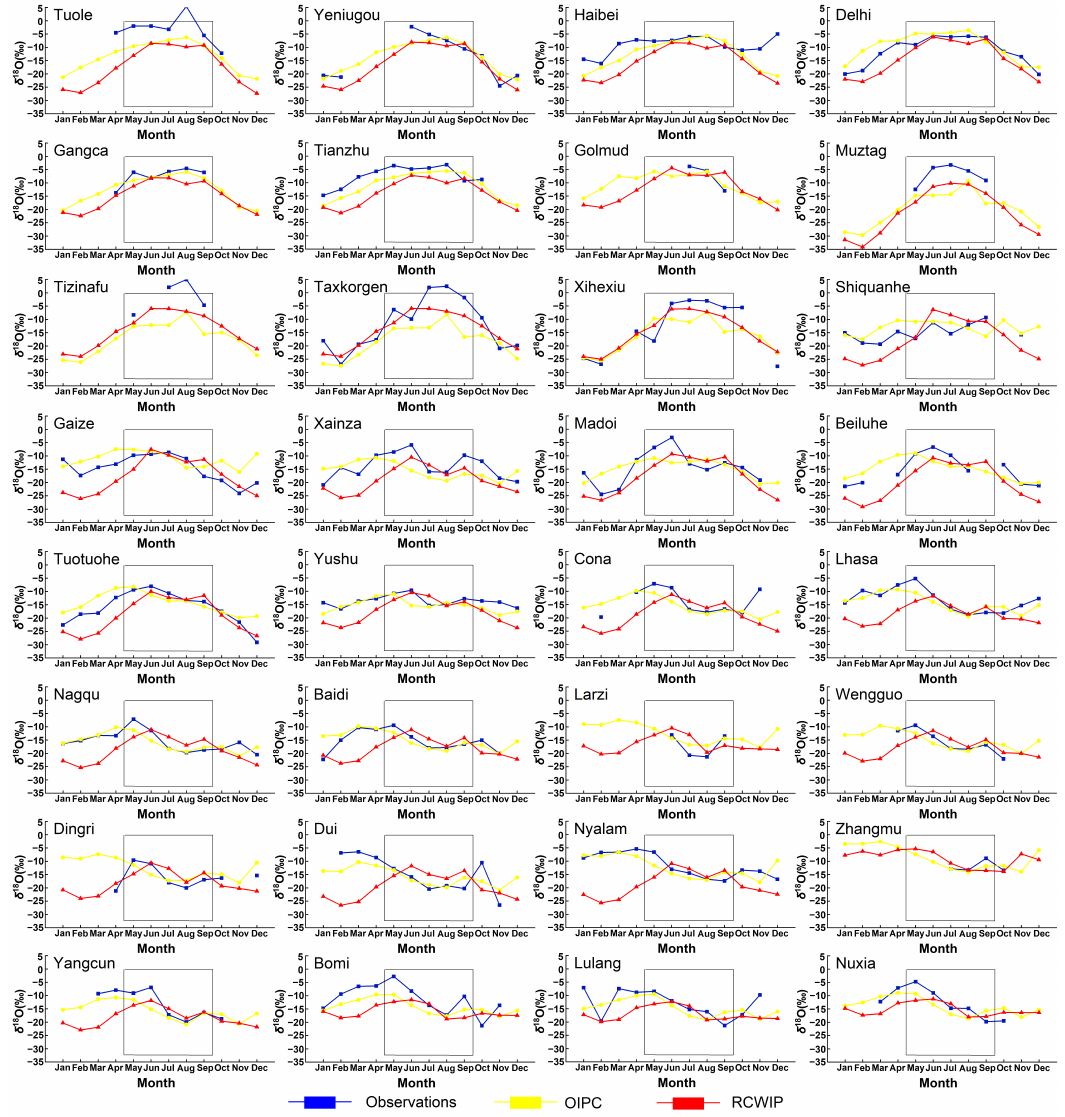
Figure 3. Monthly variations of observed and simulated δ 18 O values at 32 stations across the QTP. The frame indicates the summer half